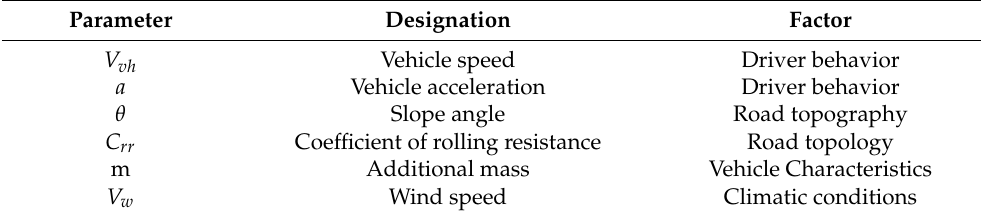
Table 5. Factors impacting energy consumption used for dataset